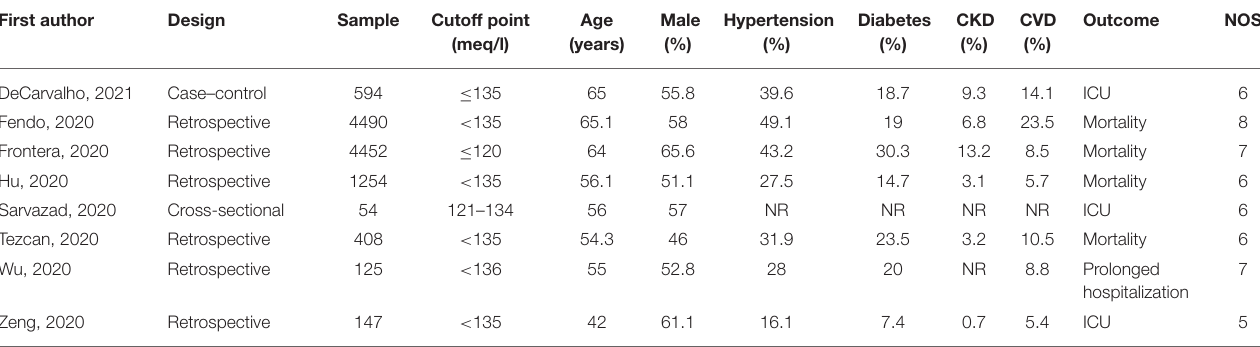
FIGURE 1 | PRISMA Flowchart. TABLE 1 | Baseline characteristics of the included